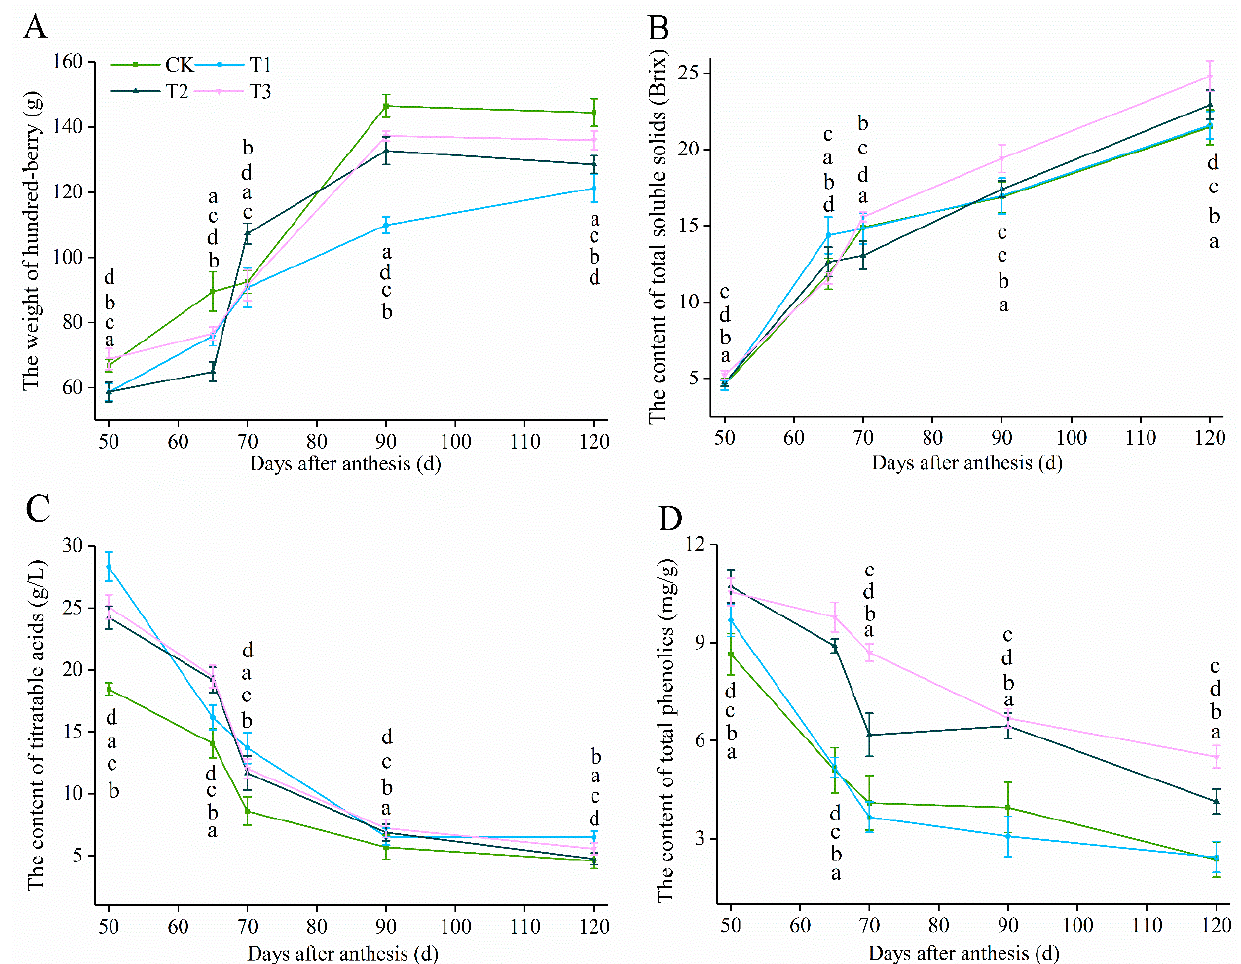
Figure 2. Physical characteristics of differently training system of ‘Cabernet Gernischt’ ( Vitis vinifera L.) berries in 2016. Overview the changes of hundred-berry weight ( A ), total soluble solids ( B ), titratable acids ( C ) and total phenolics ( D ) during developmental stages, where error bars represent the SD. Different letters denote significant differences separately for individual factors by Tukey’s test at p < 0.05 (From top to bottom represents the CK, T1, T2, T3). The details were summarized in